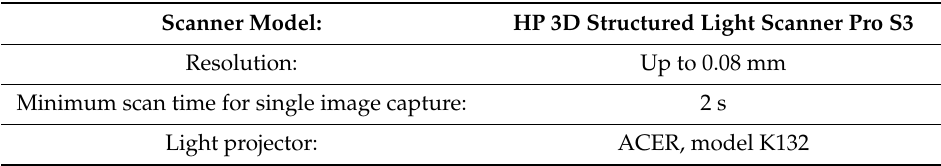
Table 5. HP brand scanner characteristics.